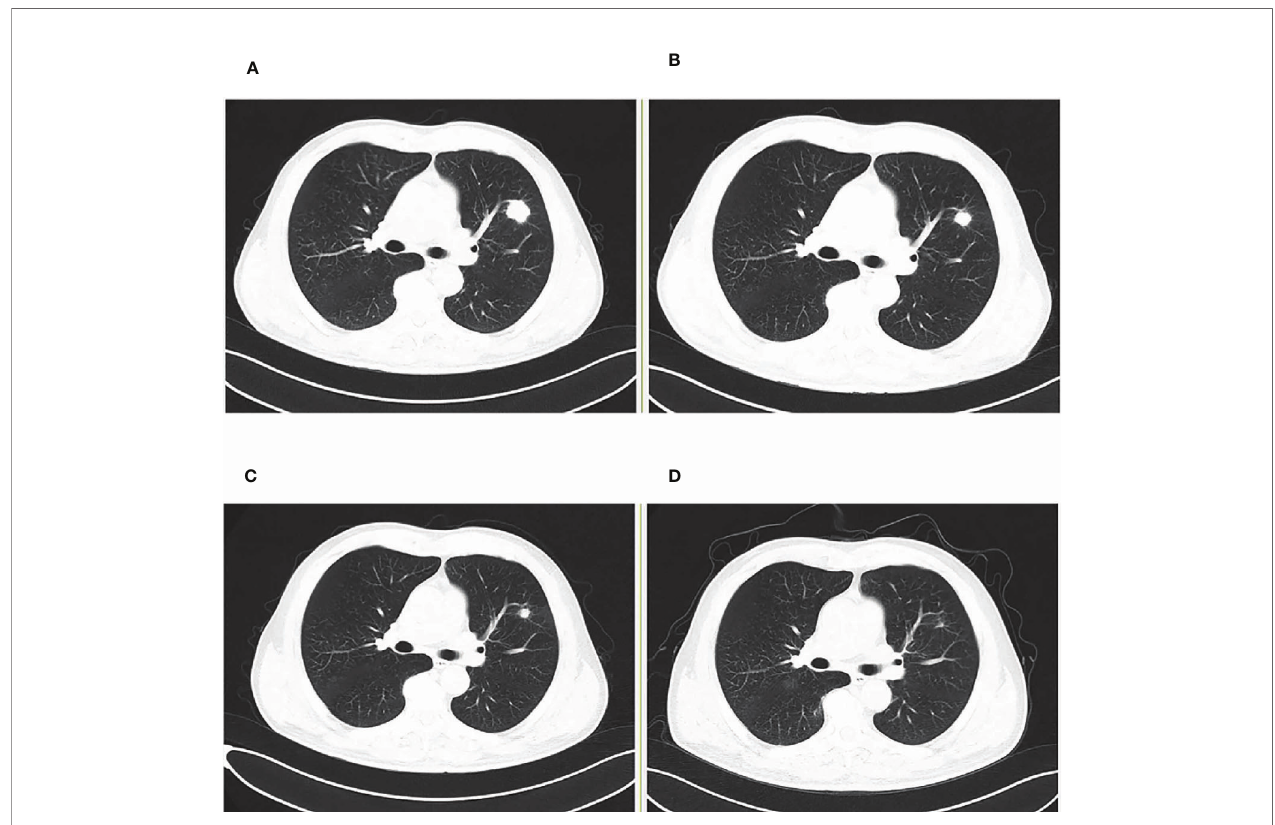
FIGURE 1 | Tumor assessment during tislelizumab treatment. (A) Baseline before treatment. (B) After two cycles of induction treatment. (C) After four cycles of induction treatment. (D) At membranous nephropathy